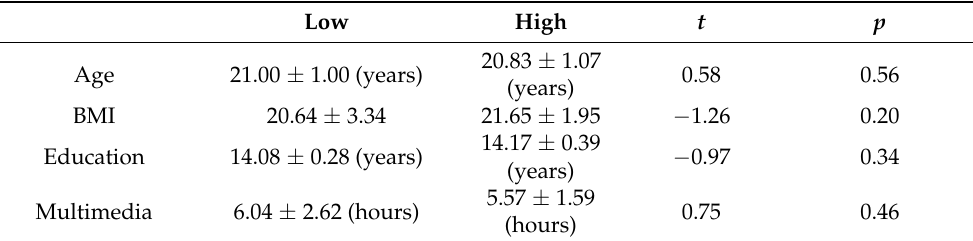
Table 1. Independent sample T test of demographic characteristics in the low- and high-CRF groups (mean ± SD). Low High t p 20.83 ± Age 21.00 ± 1.00 (years)